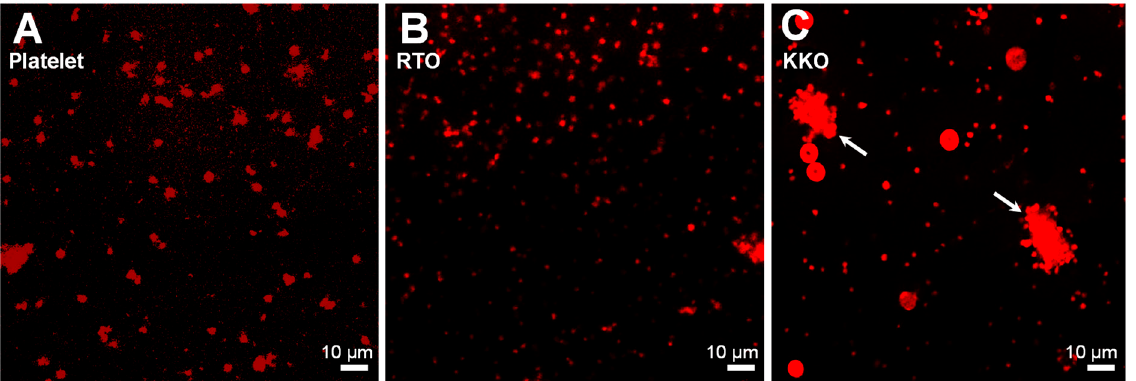
Figure 2. Visualization of platelet aggregation by confocal microscopy. No or very small aggregates and only minor change in platelet morphologies were seen in ( A ) platelet alone and ( B ) RTO, which can be considered as the background, but ( C ) KKO strongly caused platelet aggregates (arrows). The scale bar is the same for all images.